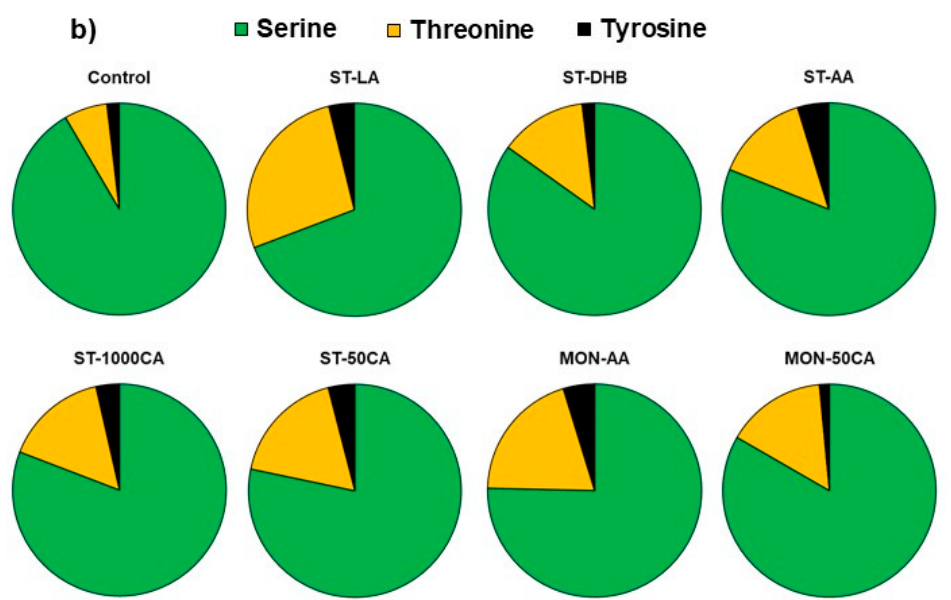
Figure 1. Phosphorylation extent and site selectivity. ( a ) Relative distribution of monophosphorylated and diphosphorylated PPs; ( b ) relative distribution of PPs with given phosphorylation sites (S, T, Y). For each method, the results of 5 parallel enrichments were combined.